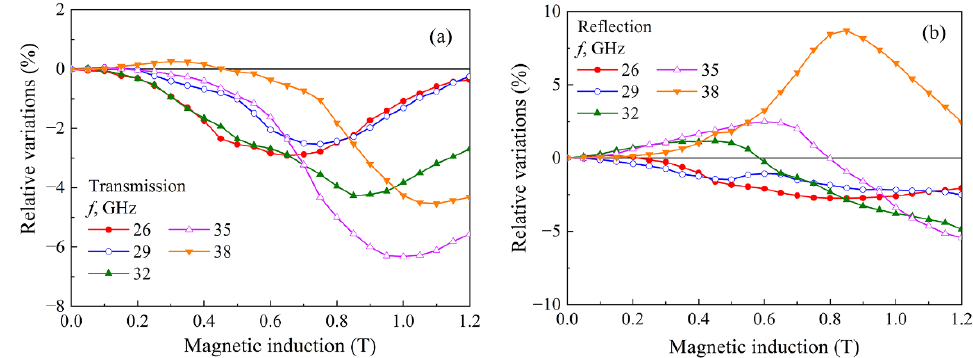
Figure 7. Dependences of the transmission coefficient ( a ) and reflection coefficient ( b ) on the magnetic field for a composite with 3.8% flakes and 2% CNT.